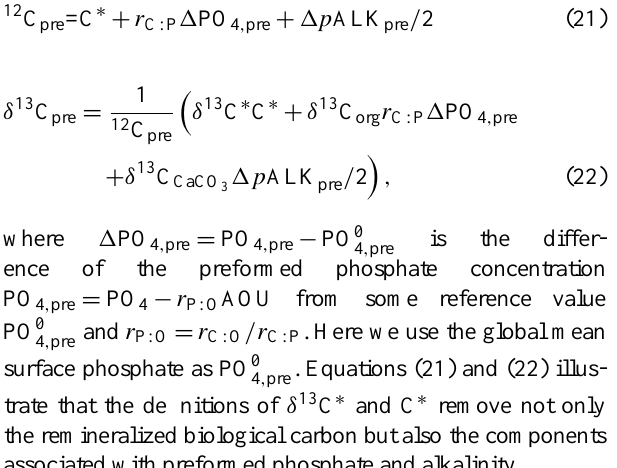
Fig. 2. Main panel (top and right axes): evolution of δ 13 C CO of atmospheric CO 2 from 1800 to 2010 used for the model forc- ing (red solid line) and original data from the Law Dome ice core (x-symbols) and air samples from Mauna Loa, Hawaii measured at Scripps Institution of Oceanography (Keeling et al., 2001) (plus symbols). 0.15‰ have been subtracted from the ice core mea- surements. This correction is applied in order to match with the Mauna Loa data and justified in part due to the observed gradi- ent ( ∼ 0 . 7‰) between the high latitude Southern Hemisphere data and those from the tropics shown in the inset panel and partly due to biases in the ice core measurements as determined by compari- son to the firn and air sample measurements. The purple and light blue lines show alternative forcing functions derived by adjusting the ice core data by 1δ 13 C= − 0 . 04‰ and using the relation of δ 13 C= − 1 . 4‰ − P A · 0 . 0182‰ppm − 1 with atmospheric CO 2 ( P A ) proposed by (Lynch-Stieglitz et al., 1995). Inset panel (bottom and left axis): δ 13 C of atmospheric CO 2 in air from Mauna Loa measured at National Oceanographic and Atmospheric Administration (NOAA) (White and Vaughn, 2011) (red dashed line), and air samples at Cape Grim, Tasmania from Francey et al. (1999) (black dotted line) and from Allison and Francey (1999) (black solid line) and from (White and Vaughn, 2011). All lines show annual mean data calculated by averaging the raw data on a regular yearly grid.